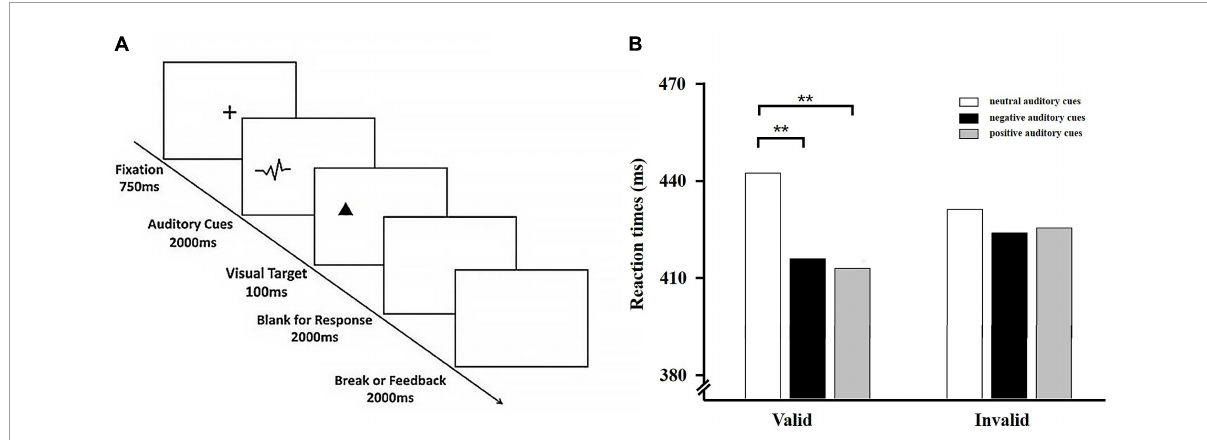
FIGURE2 (A) Typical sequence of Experiment 2. Shown in the figure is an example of a valid trail. (B) Behavioral results from Experiment 2. Average reaction times to visual targets for the six experimental conditions. Error bars indicate standard error (SE) of the mean. ** p <